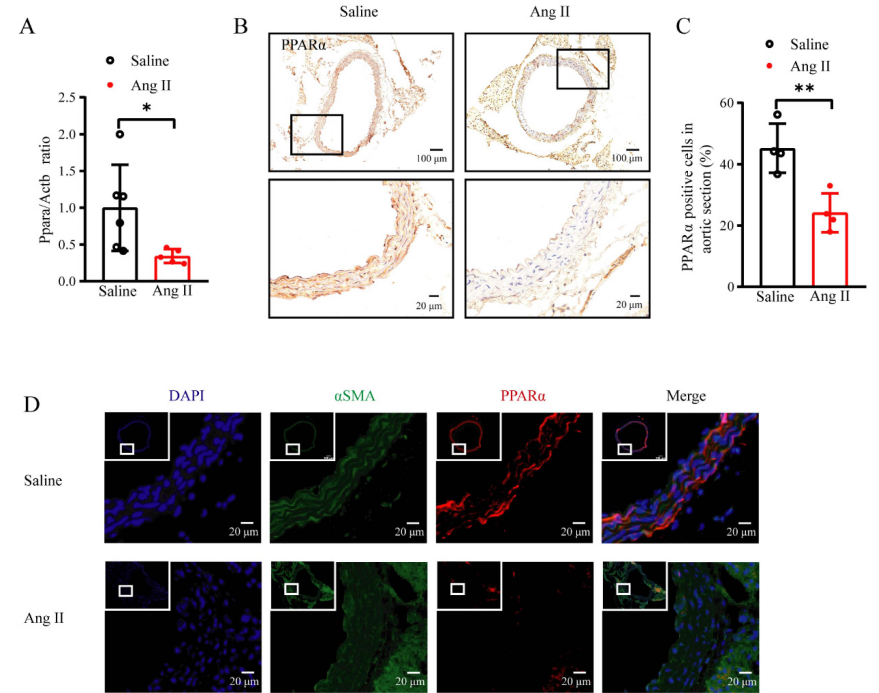
Figure 1. Ppara was decreased in Ang II − induced vascular remodeling. ( A ) mRNA levels of Ppara in aortas of Ang II infusion WT mice compared with that of saline infusion WT mice ( n = 5–6, unpaired t -test, * p < 0.05). ( B ) Immunohistochemistry staining for PPAR α in aortas of Ang II infusion mice and saline infusion mice. ( C ) Immunohistochemistry analysis of PPAR α protein level ( n = 4, unpaired t -test, * p < 0.05, ** p < 0.01). ( D ) Immunofluorescence staining for PPAR α in aortas of Ang II infusion mice and saline infusion mice. ( n = 3, blue represents DAPI staining, green represents α SMA staining and red represents PPAR α staining). Data are means ± SEM. * p < 0.05, ** p < 0.01 between